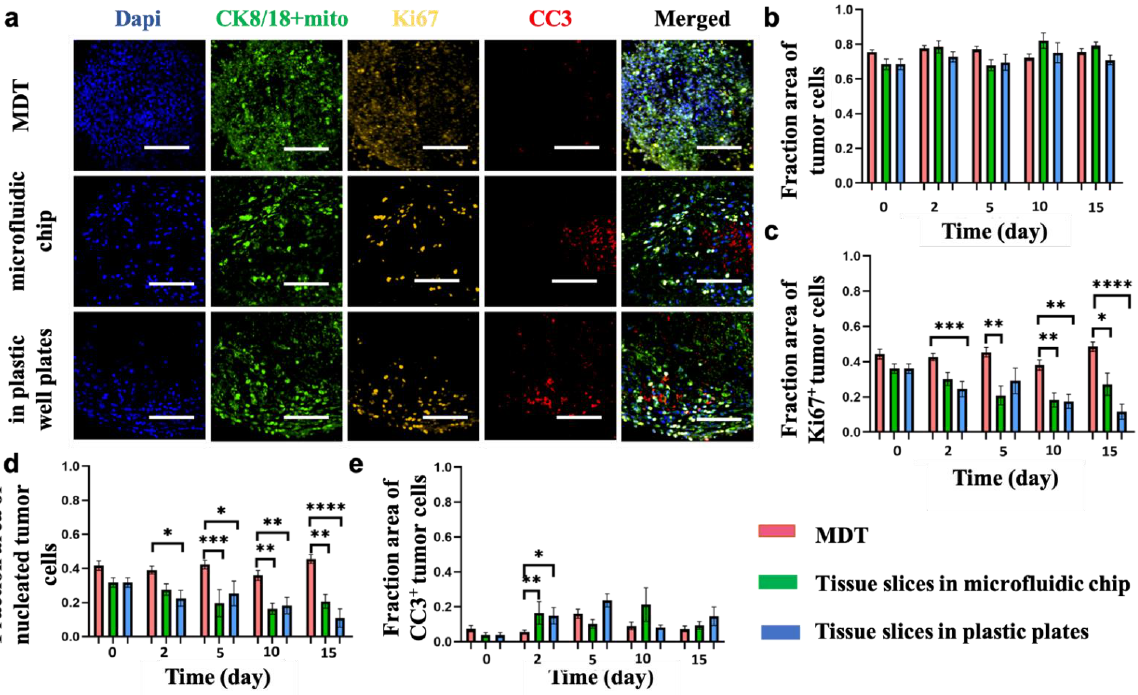
Figure 3. Tumor model viability over a 15-day culture period represented by ovarian cancer cell line xenografts (TOV21G). ( a ) Representative images of tumor models after 10 days in culture stained for nuclei (Dapi), human tumor cells (CK8/18+mito), cell proliferation (Ki67), and cell apoptosis (CC3). ( b ) IF scoring of tumor models showing stable expression of tumor-cell-specific marker (CK8/18+mito) over the 15-day period. ( c – e ) IF scoring of tumor models showing higher proliferation ( c ), larger nucleated area ( d ), and lower apoptotic cell death ( e ) in MDTs compared to tissue slices. Scale bars = 100 μm. Error bars = ± SEM. * p < 0.05; ** p < 0.01; *** p < 0.0001; **** p < 0.00001.